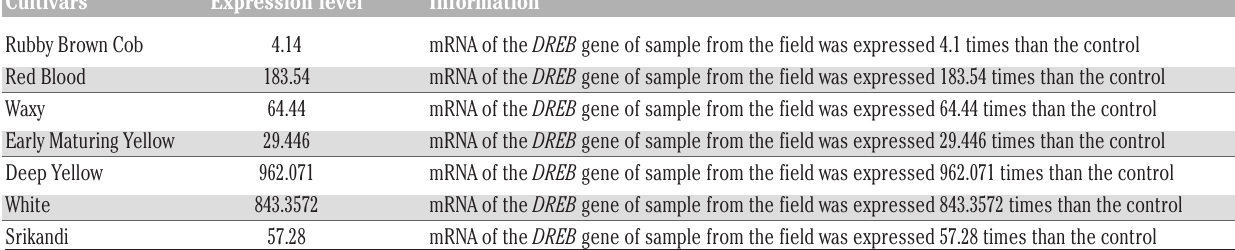
Table 2. Expression level of mRNA in DREB gene. Cultivars Expression level